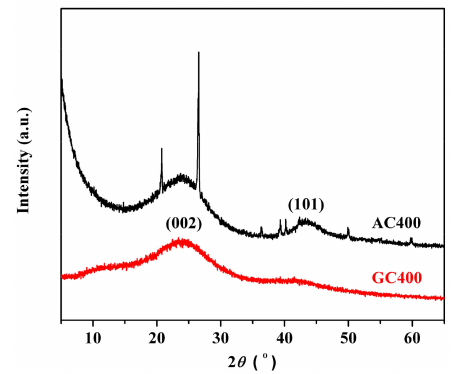
Figure 1. XRD patterns of two sulfonated carbon materials.